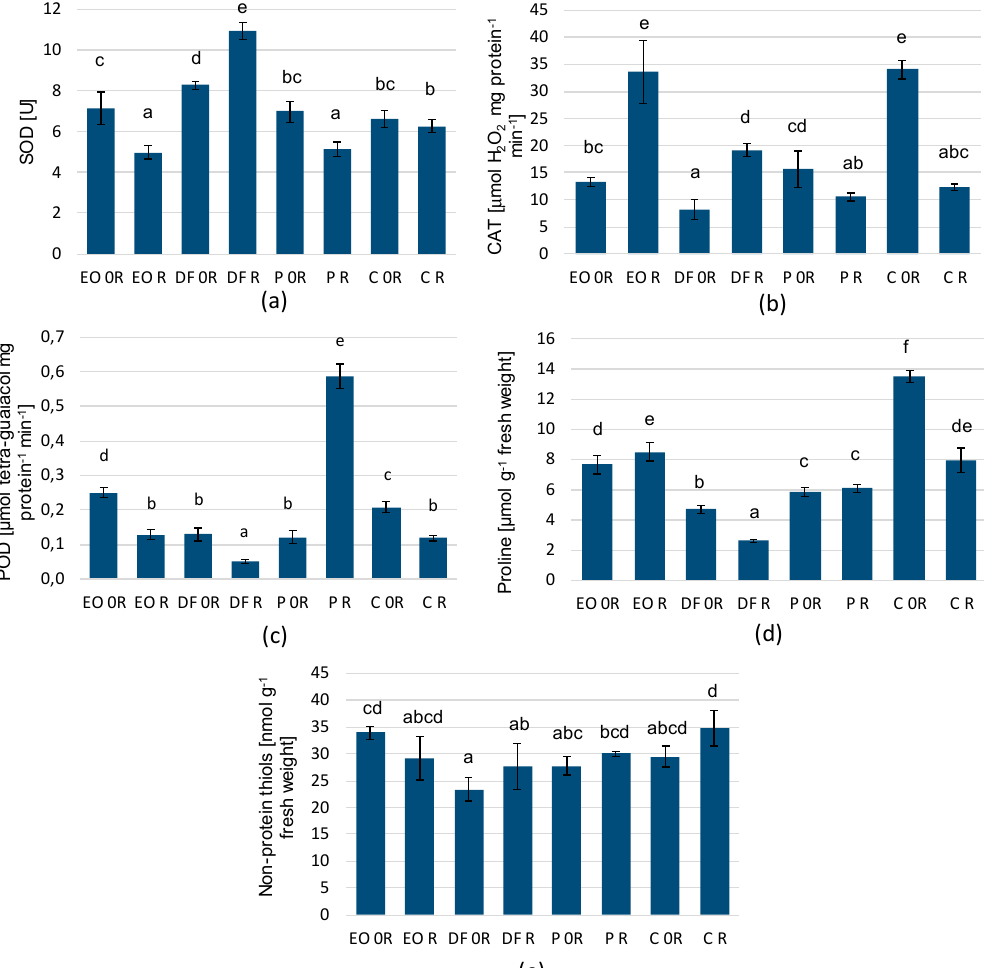
Figure 4. The effect of petroleum products and ZB-01 biopreparation on the activity of antioxidant enzymes: ( a )—superoxide dismutase, ( b )—catalase, ( c )—guaiacol peroxidase, and antioxidants: ( d )—proline, ( e )—non-protein thiols in broad bean leaves. Values marked with the same letters do not differ significantly according to LSD test at p < 0.05. Vertical bars mean SE (standard error). Symbols as in Figure 1.